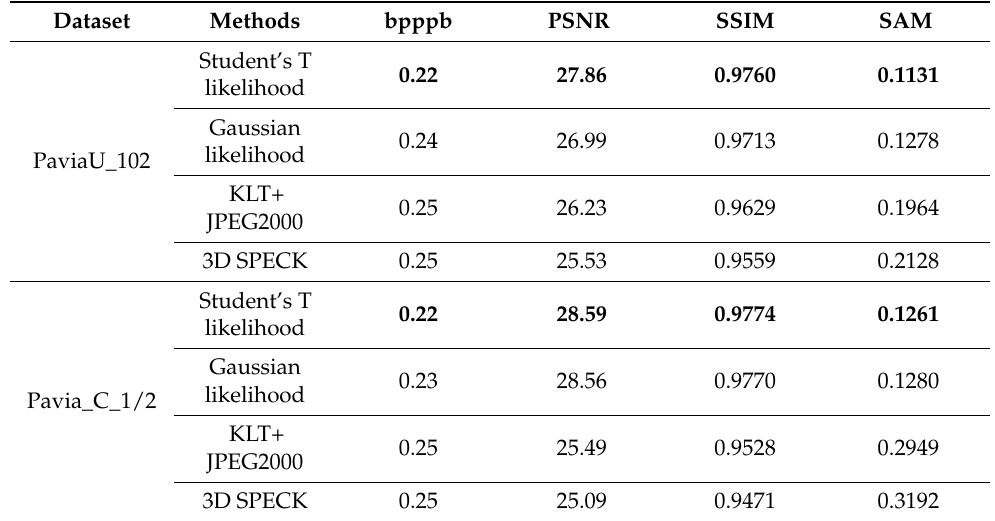
Table 2. Rate-distortion performance for relatively low bit rates; the comparatively ideal choice is marked in bold ( λ = 0.000005 ).